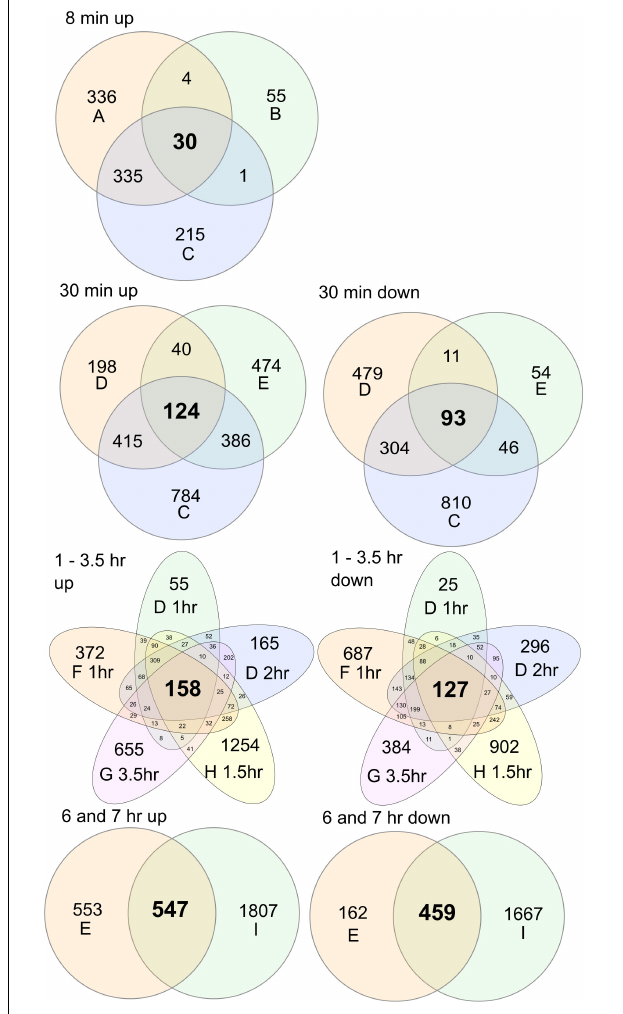
FIGURE 3 | Overlap of differentially expressed genes in different high light RNA-seq datasets. Raw data was processed with the same analysis pipeline and differentially expressed genes selected at FDR corrected P < 0.05 and a cut-off log2 ± 1 (see Supplementary Table 2 for gene lists). For experimental summary of the datasets, see Table 1 and the original publications (referred to as A–I in figure): A, Zandalinas et al., 2019b; B, Zandalinas et al., 2020; C, Fichman et al., 2020; D, Crisp et al., 2017; E, Huang et al., 2019; F, Crisp et al., 2017; G, Alvarez-Fernandez et al., 2021; H, Zandalinas et al., 2021b; I, Balfagón et al.,